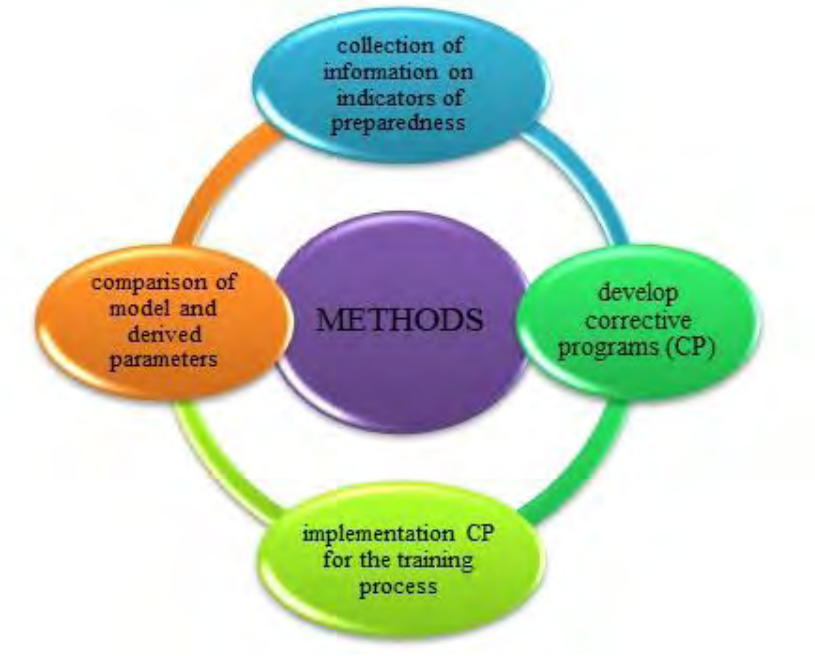
Fig.1. Methods of effective realization of training’s programs and